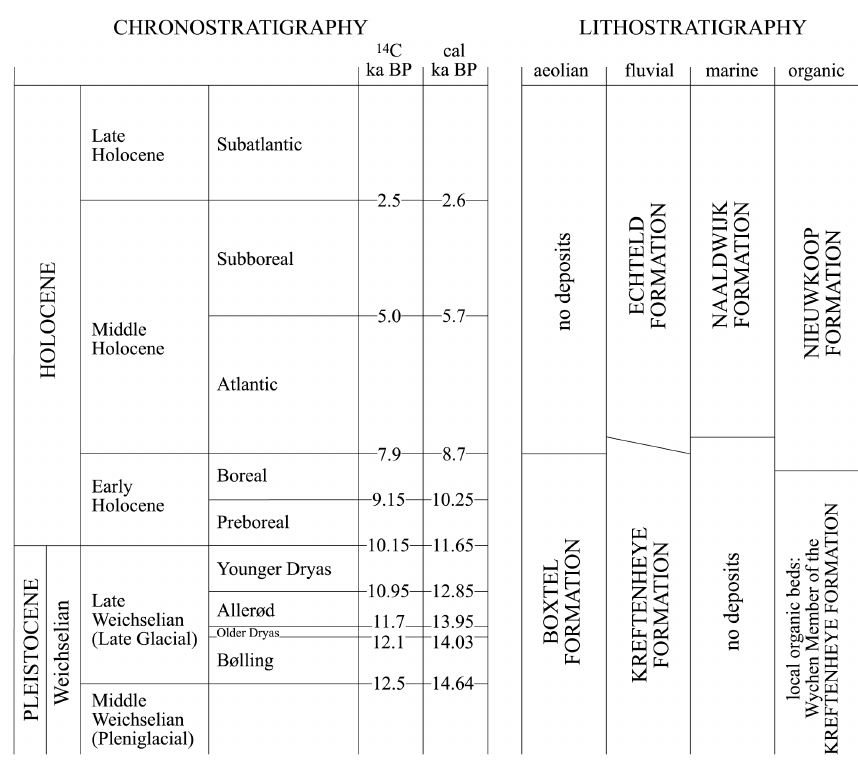
Table 1. Chronostratigraphy and lithostratigraphy for the Holocene Rhine–Meuse delta. Chronostratigraphy for the Holocene follows Van Geel et al. (1981), and chronostratigraphy for the Late Glacial follows Hoek (2008) and Rasmussen et al. (2006). Lithostratigraphy nomen- clature is following Westerhoff et al.